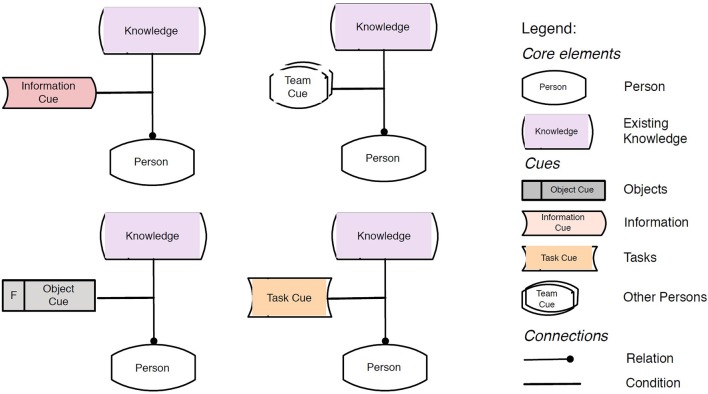
Routine-related cues. Syntax: KMDL (Maasdorp and Gronau, 2016, p. 29).